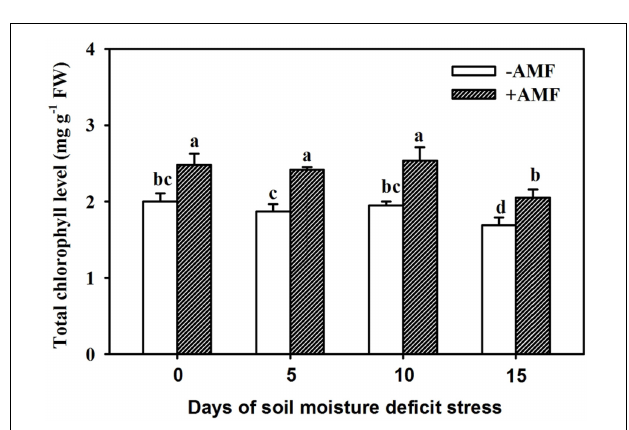
FIGURE 3 | Leaf total chlorophyll levels of trifoliate orange seedlings inoculated with and without Funneliformis mosseae during exposure to soil moisture deficit stress (SMDS) of 0-15 days. Data (mean ± SD, n = 4) followed by different letters above the bars indicate significant ( P < 0.05) differences.